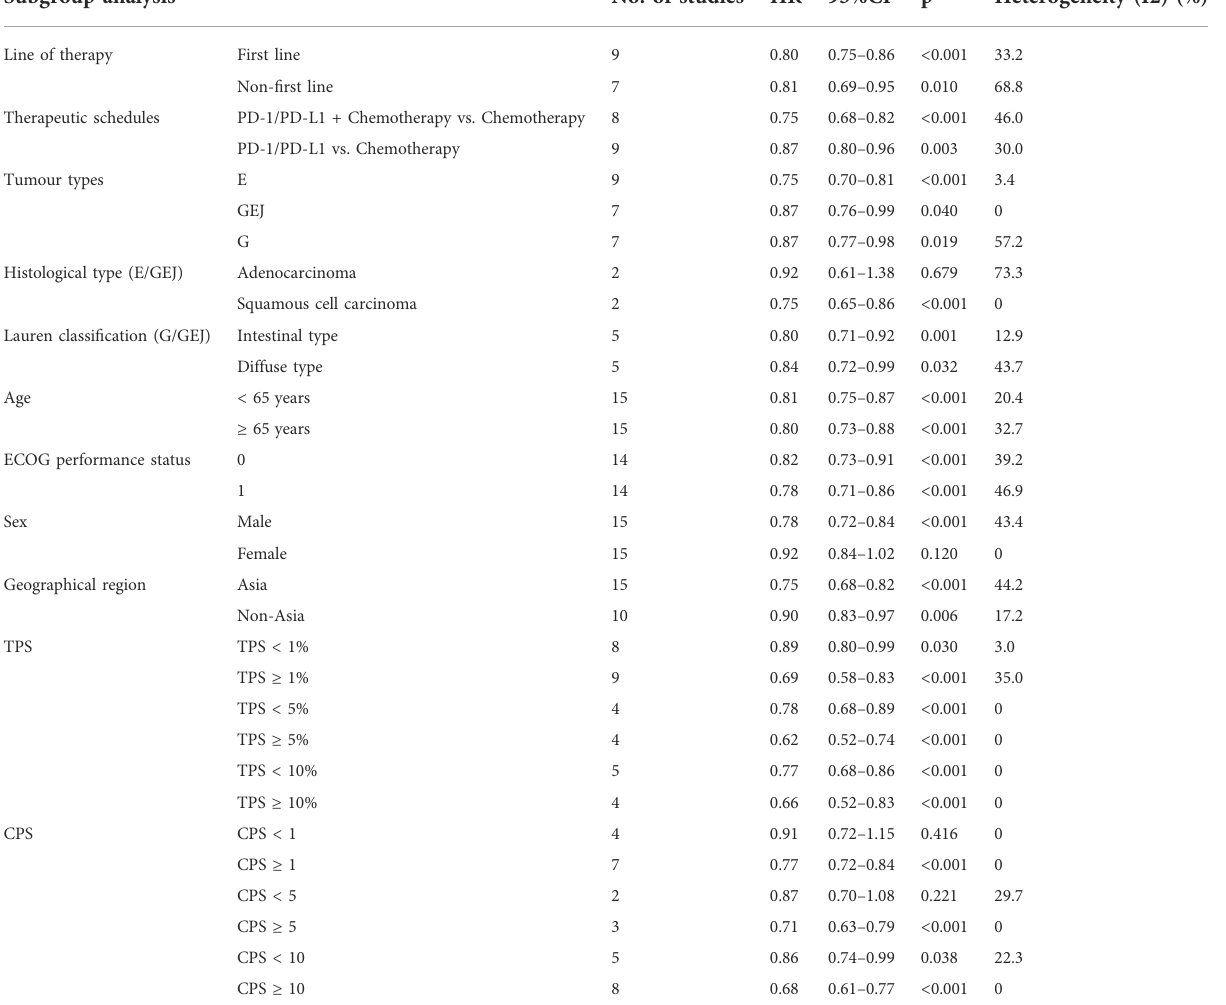
TABLE 2 Subgroup analysis of overall